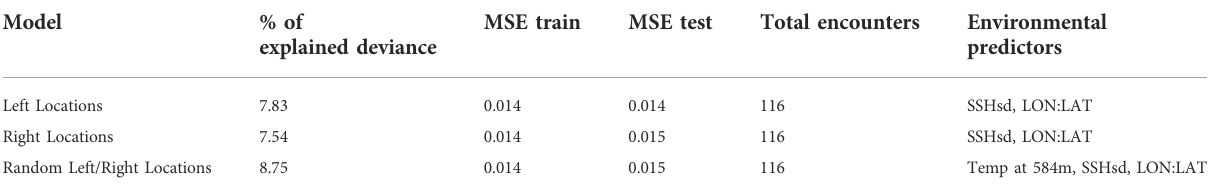
TABLE 2 Percentage of explained deviance, mean squared errors, total encounters, and selected environmental predictors for models comparing data from left and right locations of localized acoustic encounters.